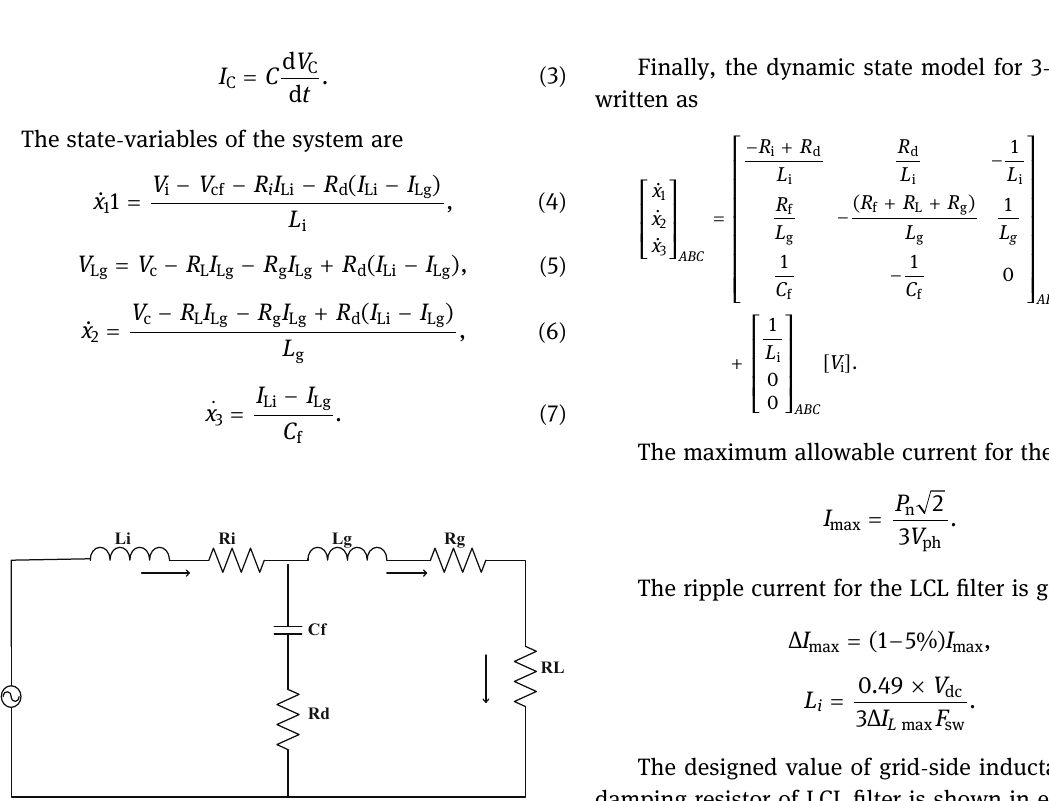
Figure 5: Standalone PV system with its control scheme in abc reference frame.